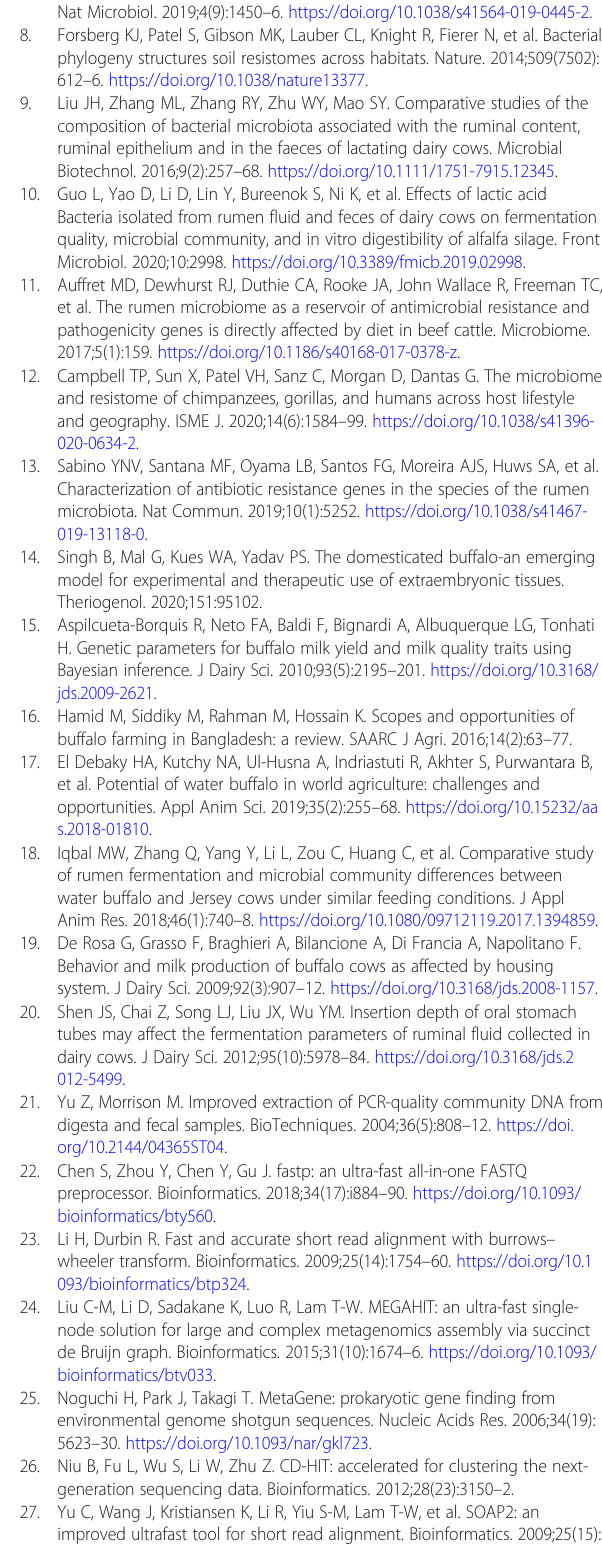
in individuals. Table S3. The significantly different CAZymes encoded genes identified in the rumen microbiota between dairy cows and buffaloes. Table S4 . ARGs and their abundance in dairy cows and dairy buffaloes. Table S5. ARGs and their AMR phenotypes in the dairy buffaloes. Table S6. The relative abundance of unique ARGs in different age groups of dairy